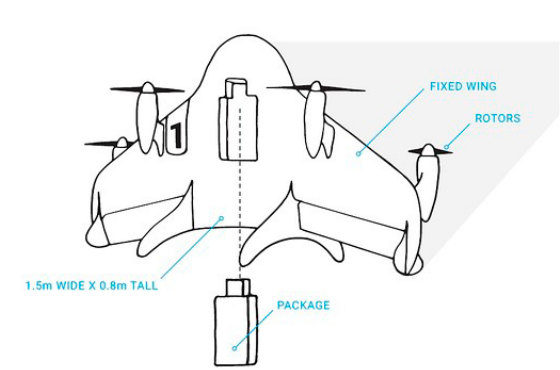
Fig. 6. Google X wing vehicle (Source: http://thehigherlearning. com/2014/09/01/secret-google-x-project-bringing-us-a-step- closer-to-drone-deliveries-video/)